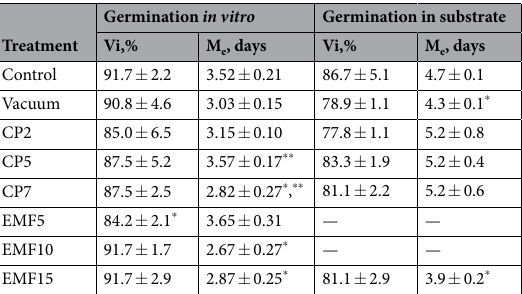
Table 1. Indices of germination kinetics of sunflower seeds derived from Richards plots. Mean values ± standard error of mean are presented (n = 3 replicates, 30 seeds in one replicate), * significantly different from the control group (p ≤ 0.05); ** significantly different from the vacuum group (p ≤ 0.05).